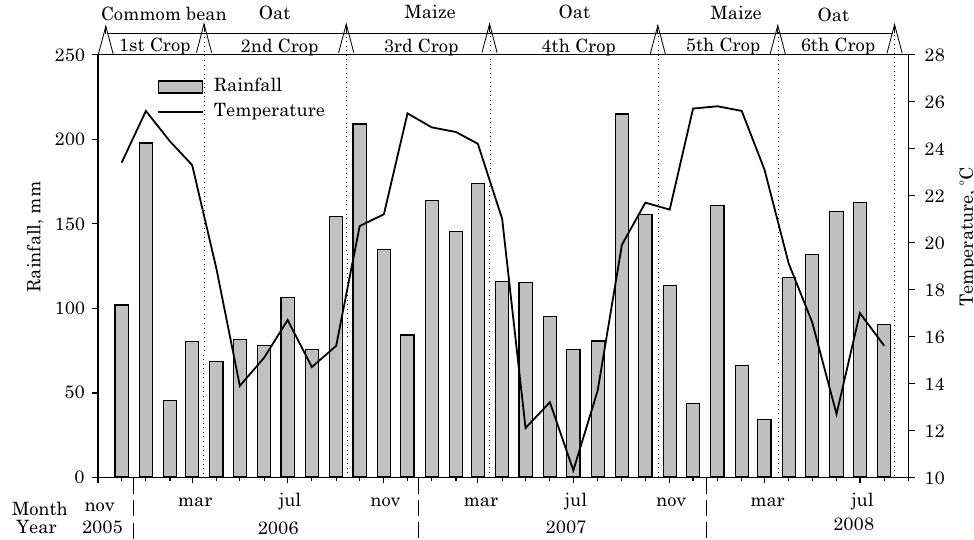
Figure 1. Mean values of temperature and rainfall in the experimental period. Table 1. Characteristics of pig slurry and turkey manure applied in the 2005 to 2008 growing seasons